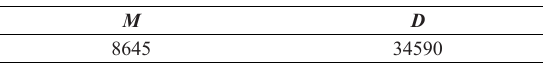
Table 3. Mathematical expectation and variance of the over- haul period.